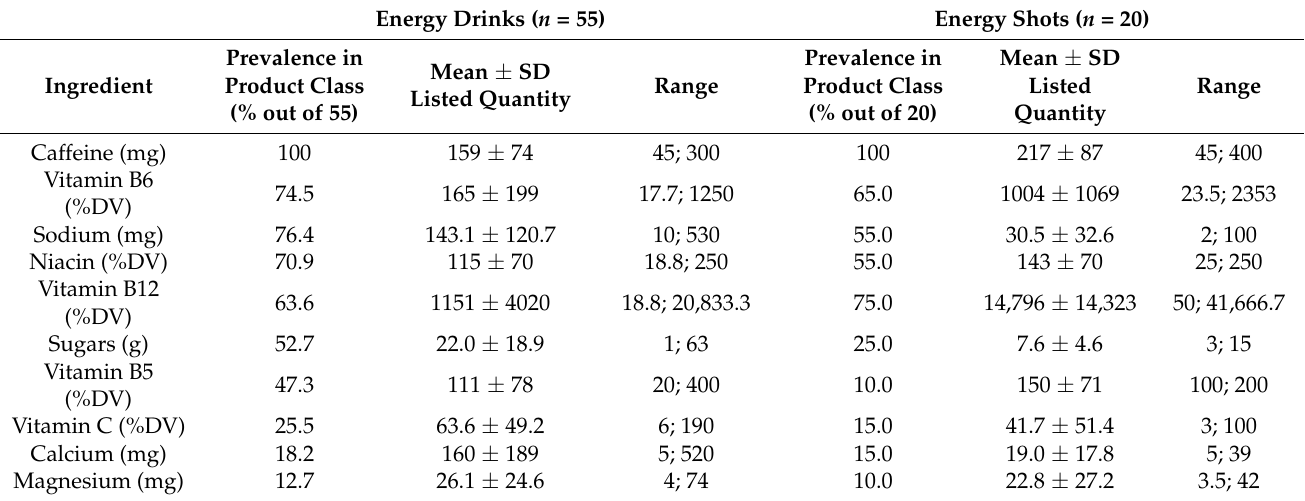
Ingredient prevalence represents the proportion of each ingredient per product class.